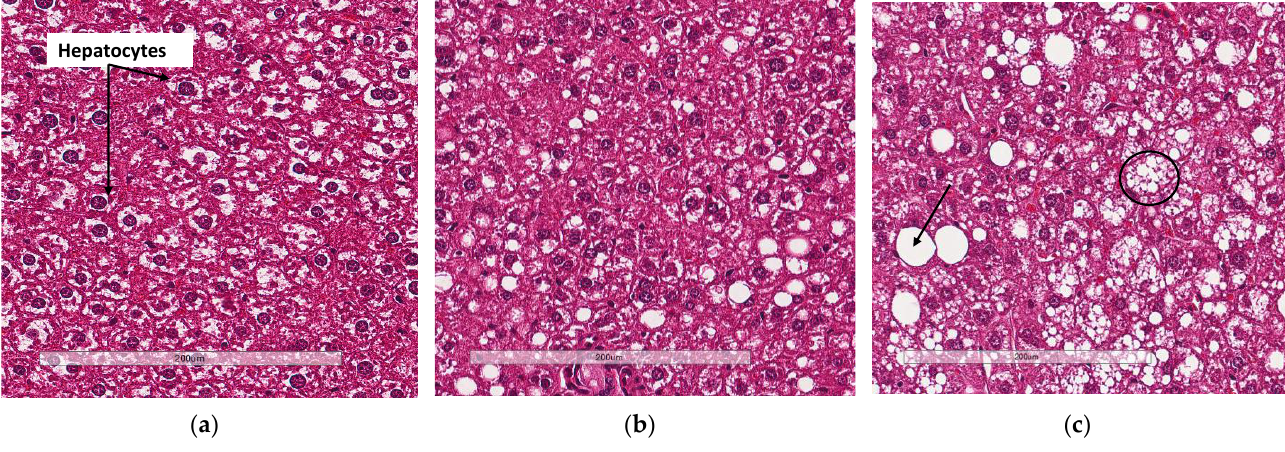
Figure 5. Lipid accumulation in the liver. H&E-stained liver sections showed the presence of micro- and macrovesicular steatosis in WTHFD ( c ), which was reduced in KOHFD ( b ) and absent in WTCD ( a ). Magnification = 20×. Scale bar = 200 µm.